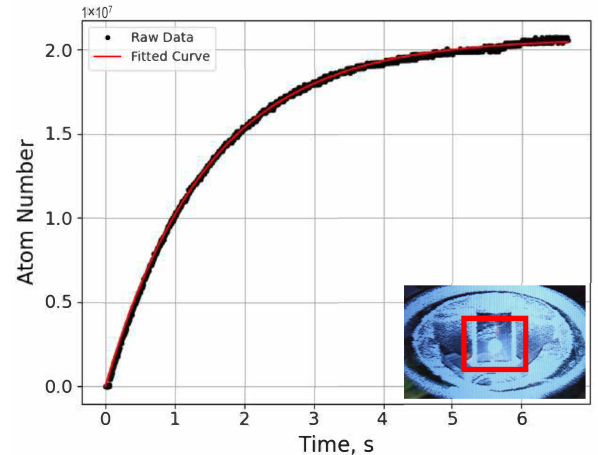
Figure 4. Example MOT loading curve taken while on the ground with the ion pump in operation. The loading curve has been fitted with equation 2 from reference [28]. The inset shows a photo of prism MOT. The atom cloud is highlighted within the red